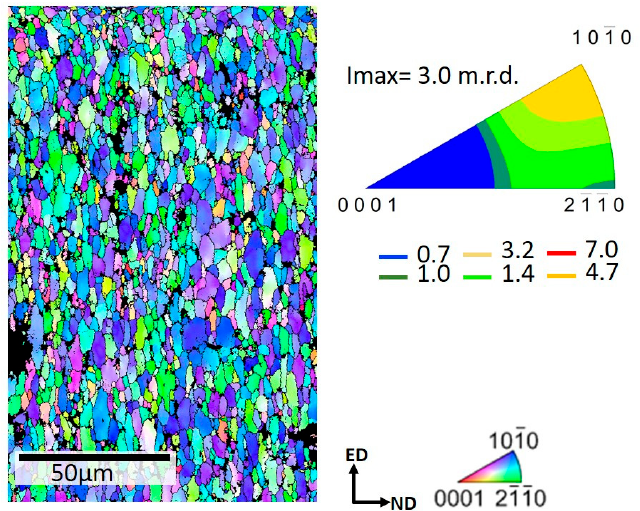
Figure 11. Inverse pole figure map and respective local texture measured near the fracture of a sample deformed at 250 °C and a strain rate of 10 − 4 s − 1 .